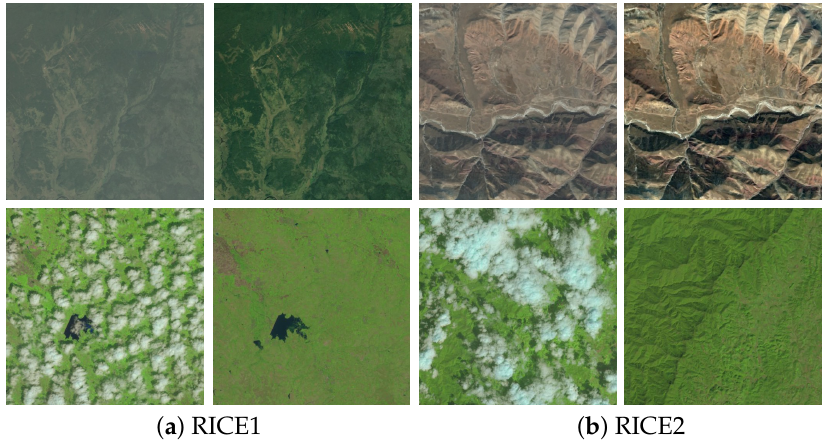
Figure 6. A typical sample presentation of the RICE dataset: ( a ) RICE1 dataset—images with thin cloud are on the left and without cloud are on the right. ( b ) RICE2 dataset—images with thick clouds are on the left and without clouds are on the